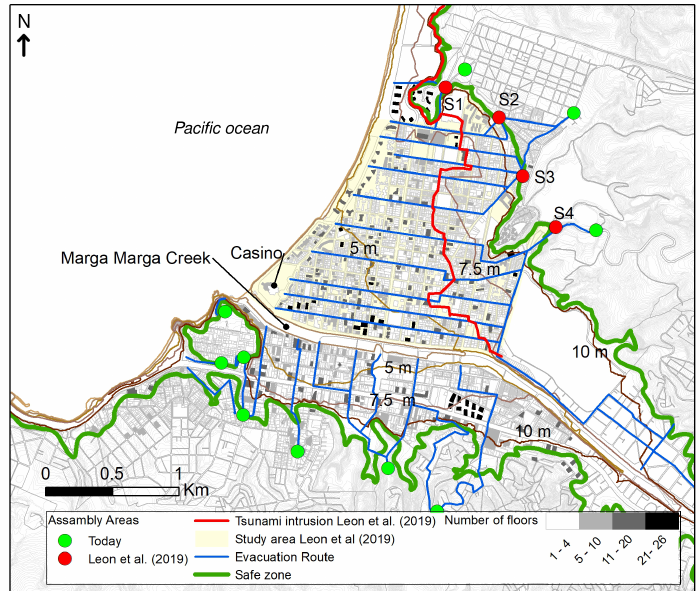
Figure 7. Map of Viña del Mar’s downtown. Green dots are the assembly areas in case of a tsunami; green lines demarcate the safe zone; blue lines are the tsunami evacuation routes; these three have been established by the municipality to date. Brown lines are contours every 2.5 m. The gray scale indicates the number of floors of existing buildings. The Población Vergara neighborhood (yellow colored area) maximum tsunami inundation extent [31] is delimited by the red line. Four assembly areas are shown (red